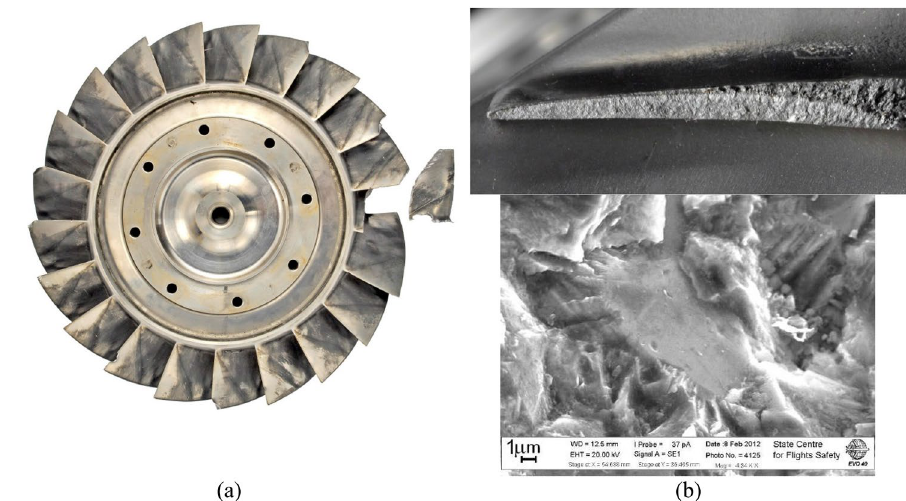
Fig. 1 Appearance of the destroyed titanium disk of Tupolev Tu-204 aircraft ( a ) and fracture surface of the destroyed blade ( b ) [8, 9]